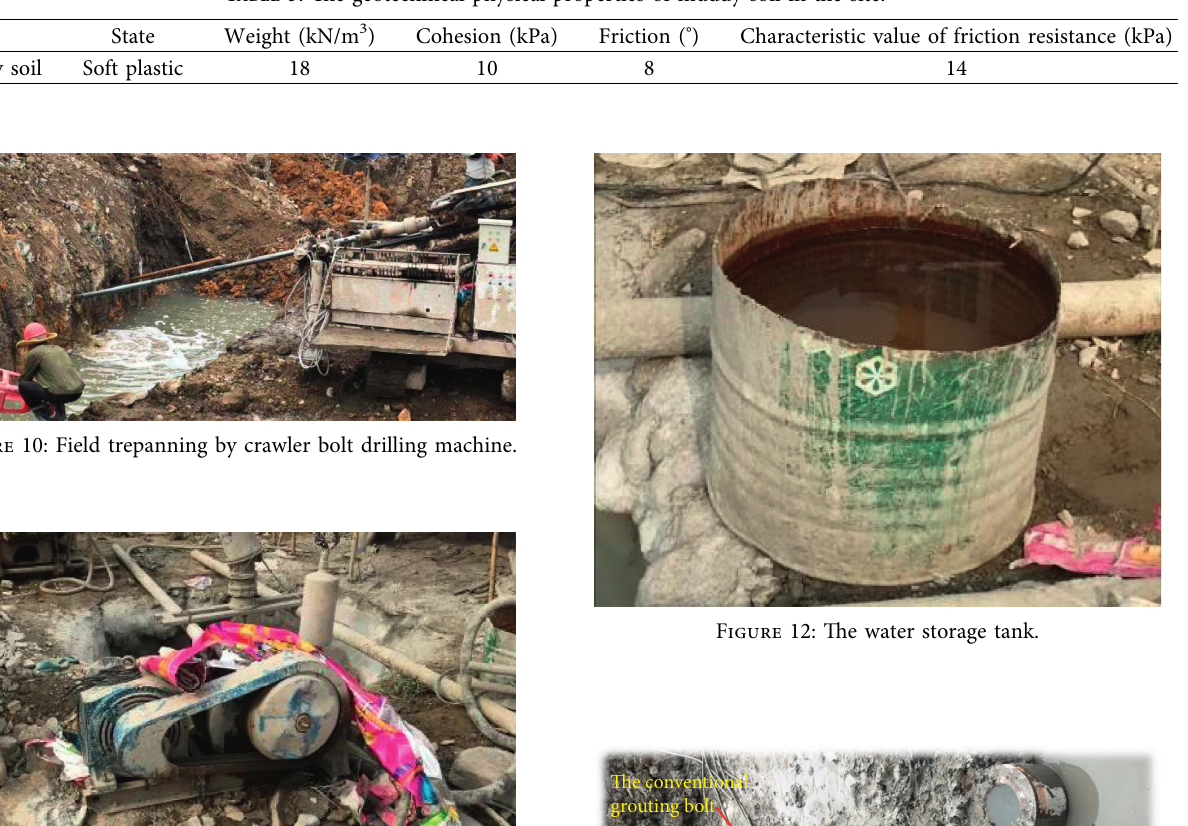
Table 3: The geotechnical physical properties of muddy soil in the site.